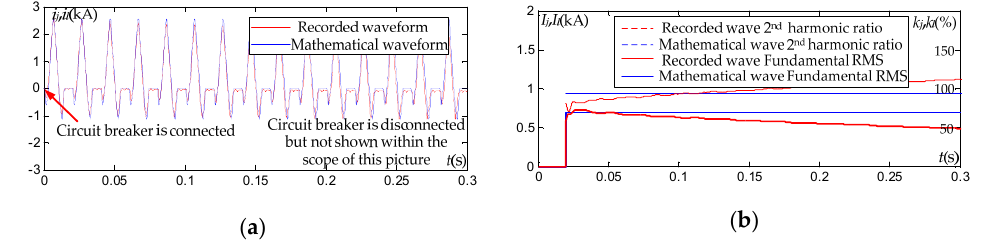
Figure 6. Graphical representation for waveform Number Three: ( a ) original waveform; ( b ) fundamental RMS and second harmonic ratio.